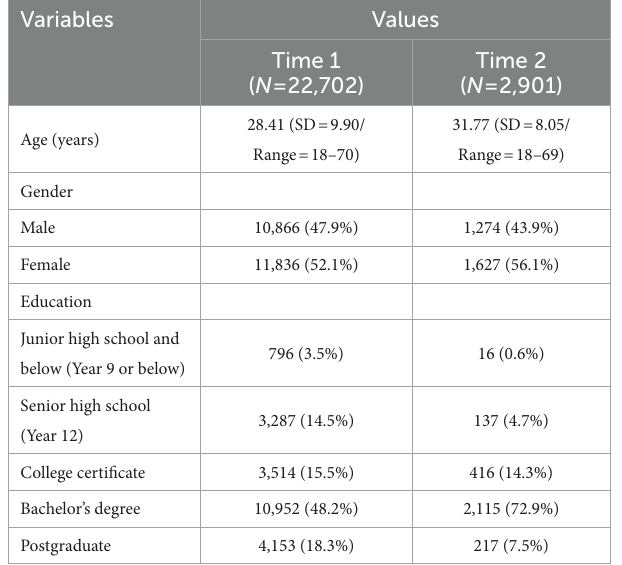
TABLE 1 The sample